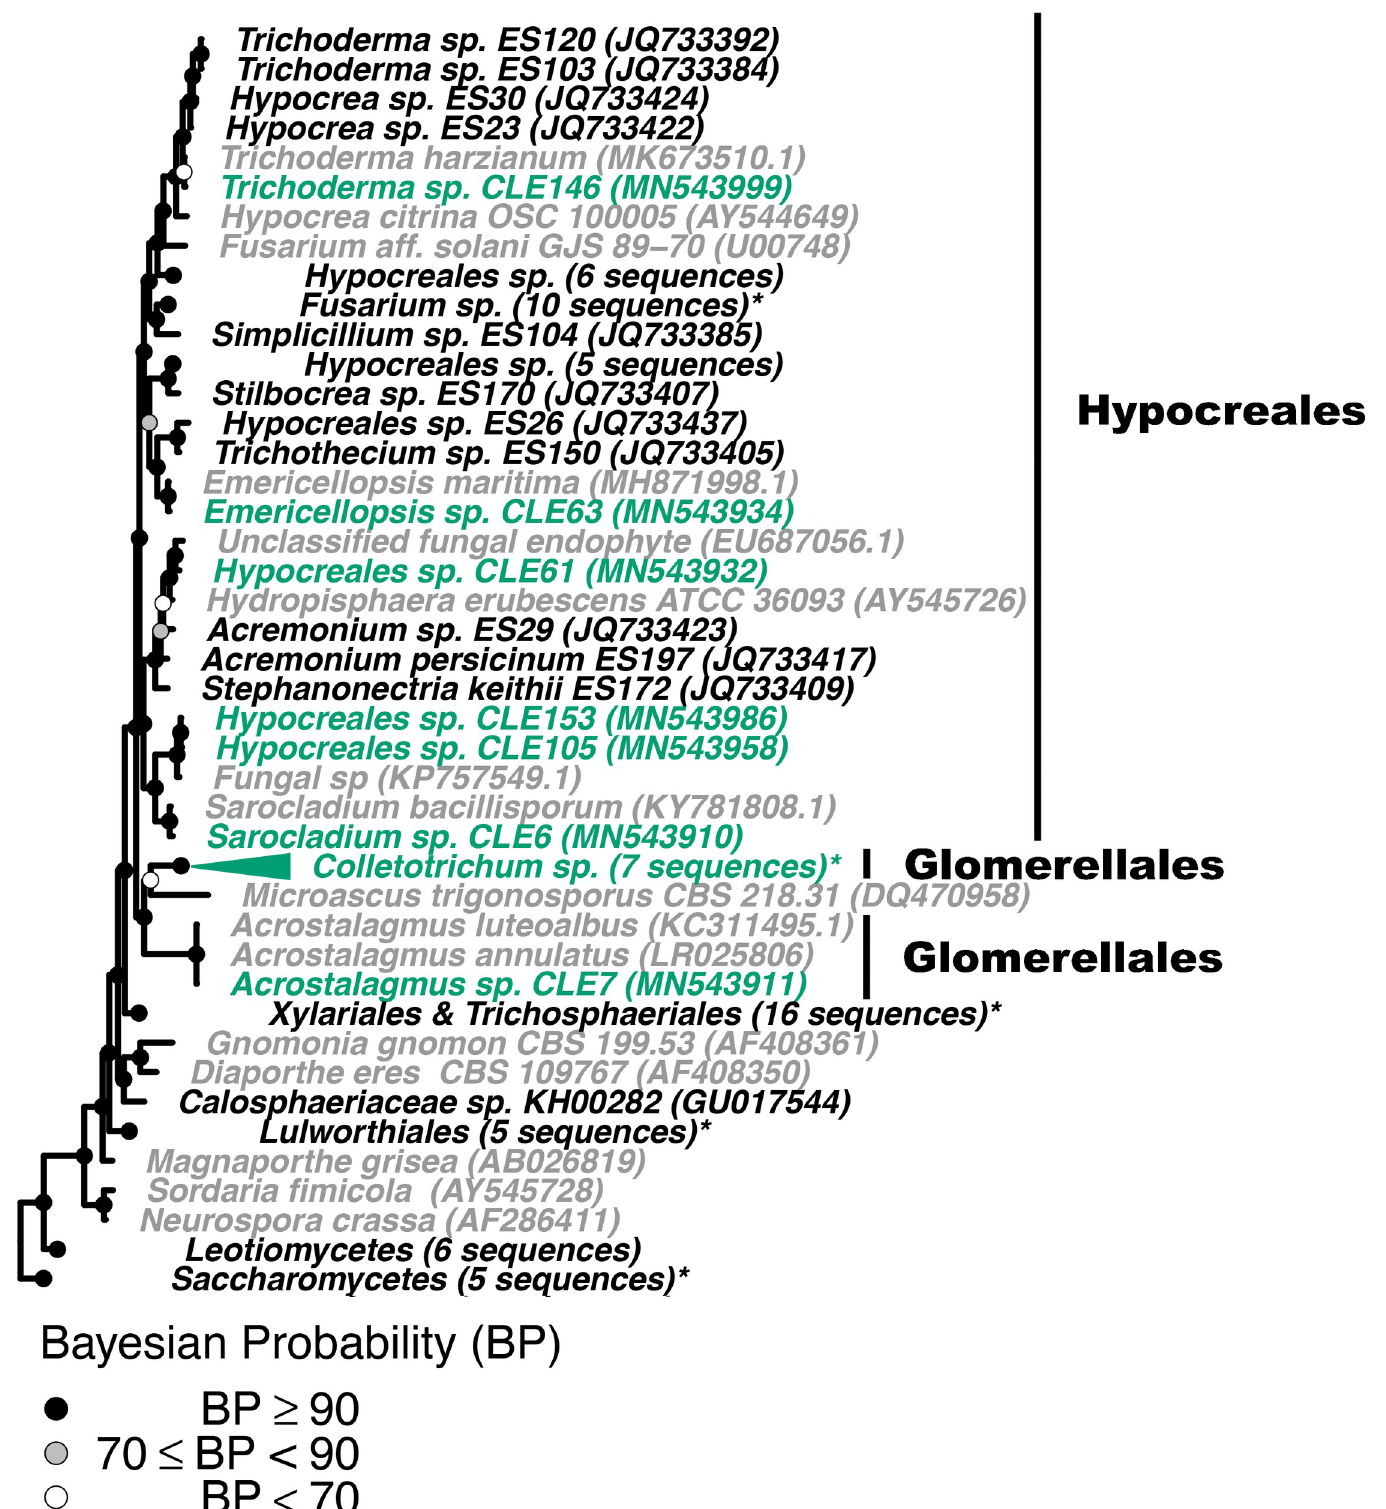
Fig 5. Phylogenetic placement of seagrass fungal isolates in the Sordariomycetes. A molecular phylogeny of 28S rRNA genes for isolates in the Sordariomycetes was constructed using Bayesian inference. This alignment was generated using MAFFT (v. 7.402) on the CIPRES Science Gateway web server, trimmed using trimAl